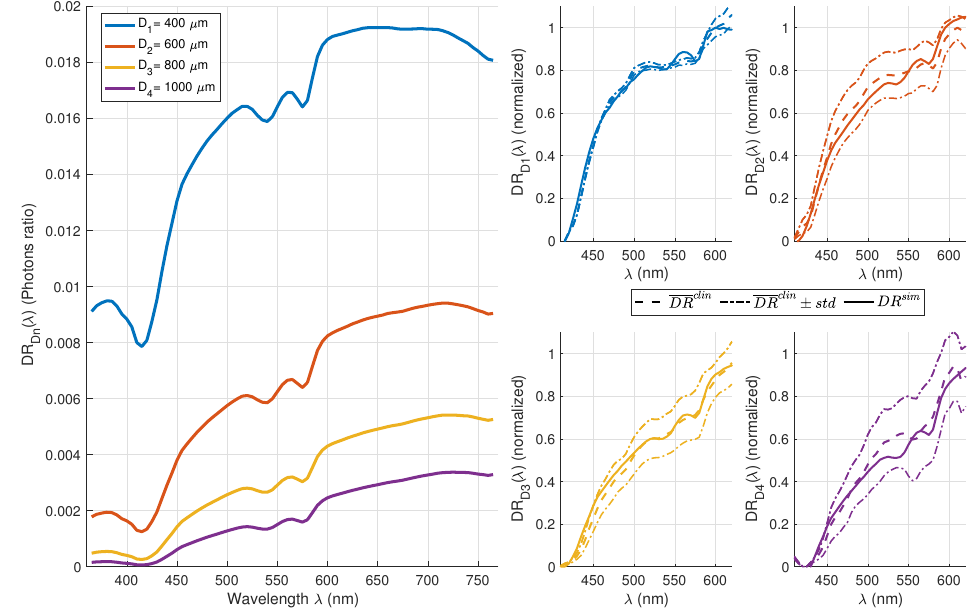
Figure 3. DR spectra simulated for the four SD distances ( left ). The considered medium is the healthy skin model with intermediate thicknesses, mean dermal blood content and phototype I. The four other figures ( right ) show the superposition of the normalized DR spectra from SpectroLive acquisition on a patient’s wrist, within a confidence interval calculated as DR clin ± std (dash-dotted line), as well as the estimated DR sim (continuous line) from our